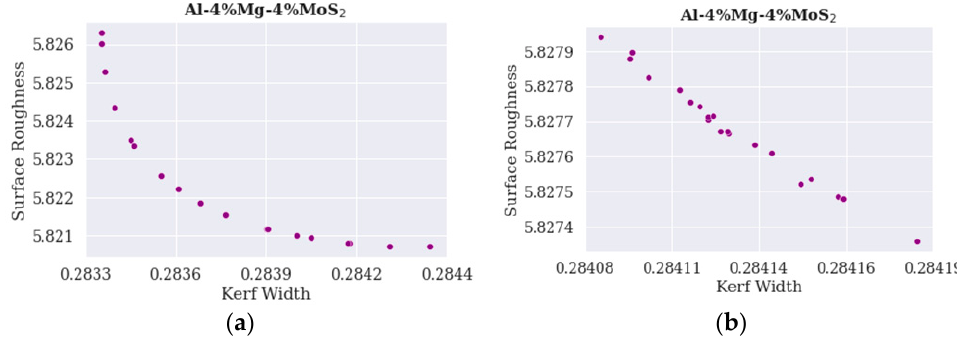
Figure 7. Pareto optimal solutions for Al-4%Mg-4%MoS 2 by ( a ) NSGA-II, and ( b ) MOPSO. For the Al-4%Mg-4%MoS 2 sample, Pareto-optimal solutions are obtained at 11–12 A of peak current, 50 µ s of pulse on time, and 30 V of gap voltage.